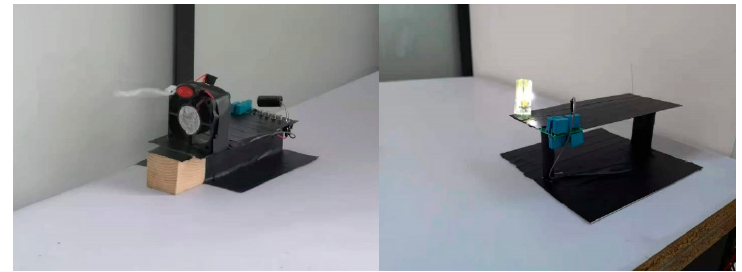
Figure 19. Cooling fan load and lamp load.